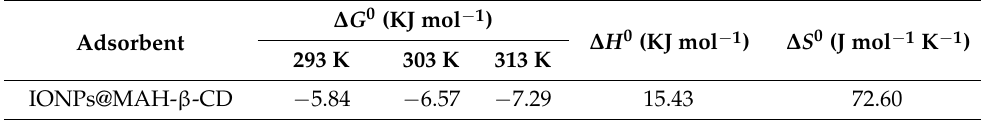
Table 2. Thermodynamic parameters of IONPs@MAH- β